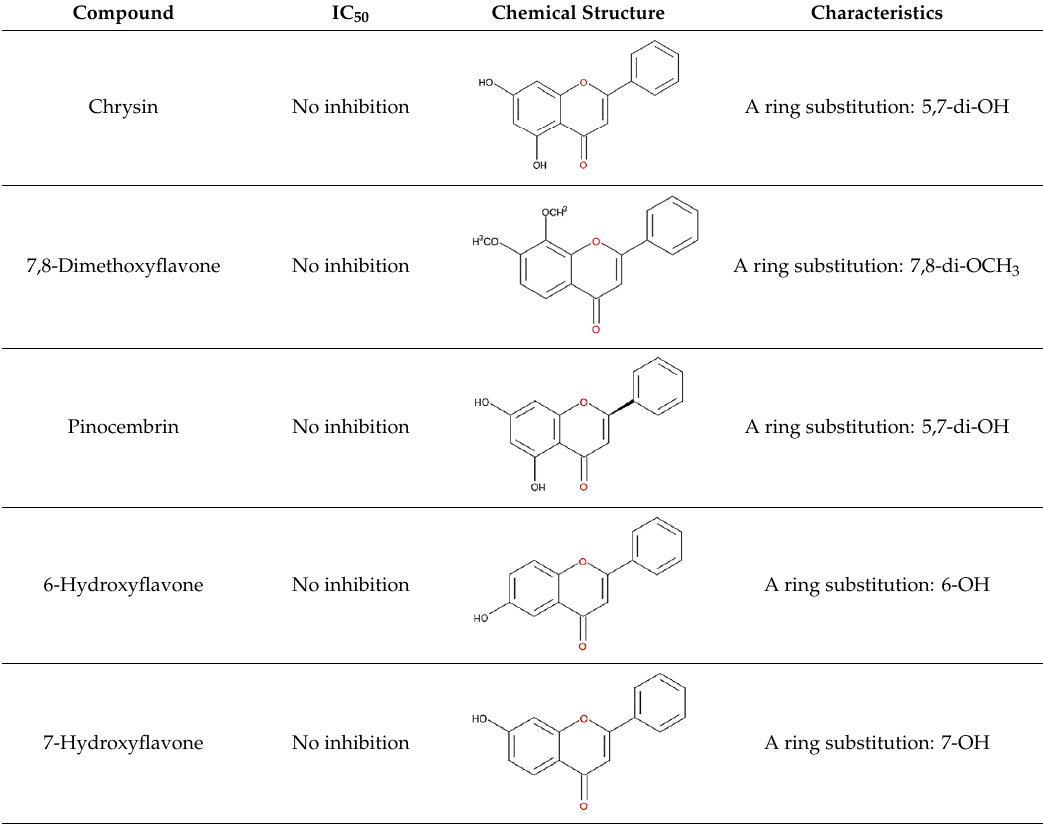
Table 2. Flavonoids with substitutions on both the A and B rings and with the IC 50 to ODC. Compound